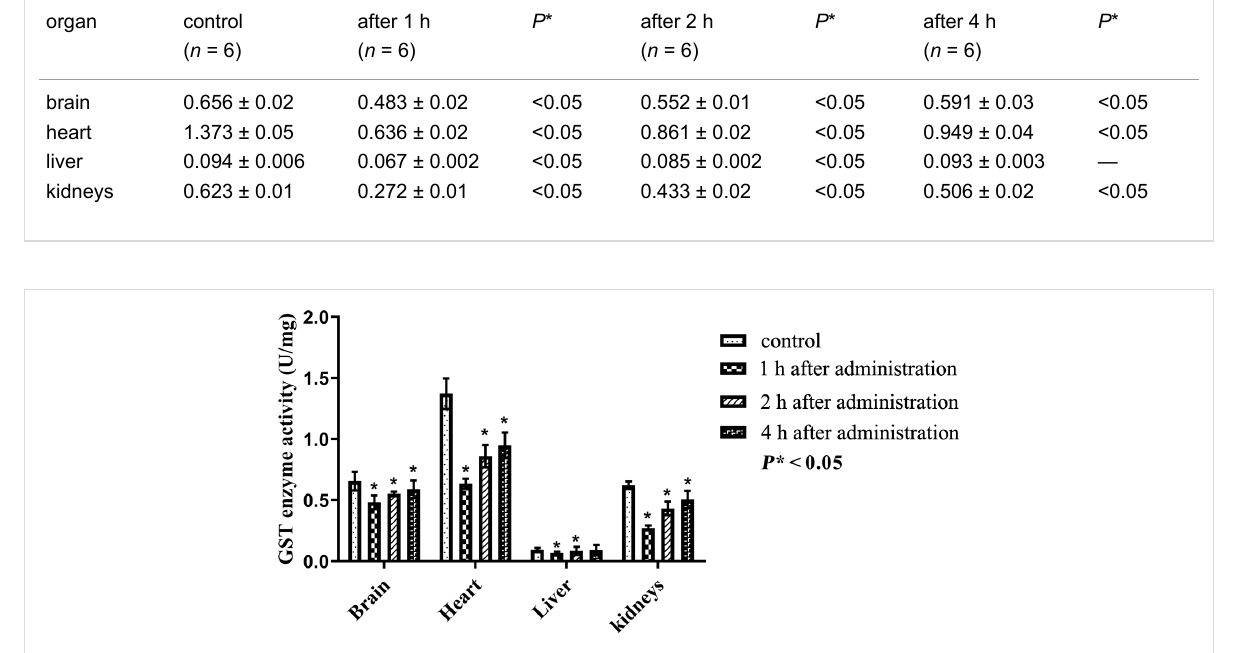
Table 5: Activity of GST normalised to the wet-tissue mass (U/mg) after administration of PEGylated nano-graphene oxide in different organs after dif- ferent periods of time (mean ± standard deviation). organ